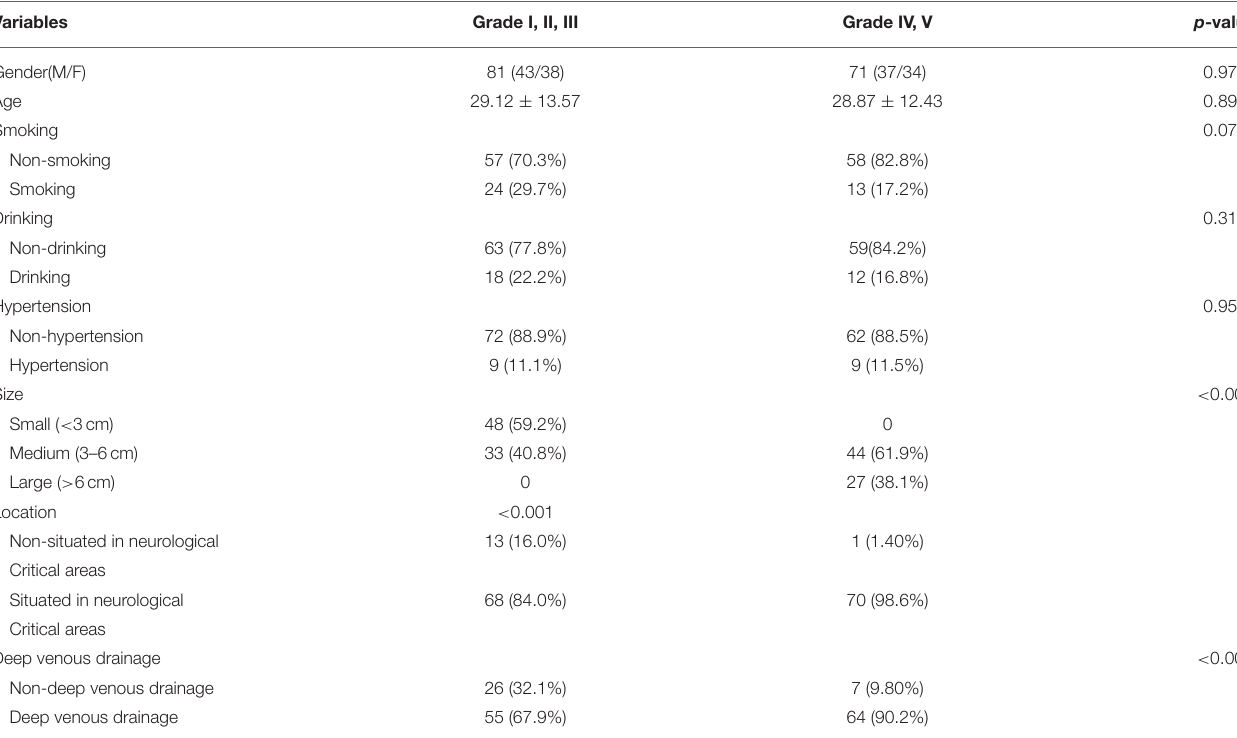
TABLE 1 | Baseline characteristics of patients with lower levels of brain AVM (Grade I,II,III) and higher levels of brain AVM (Grade IV, V).